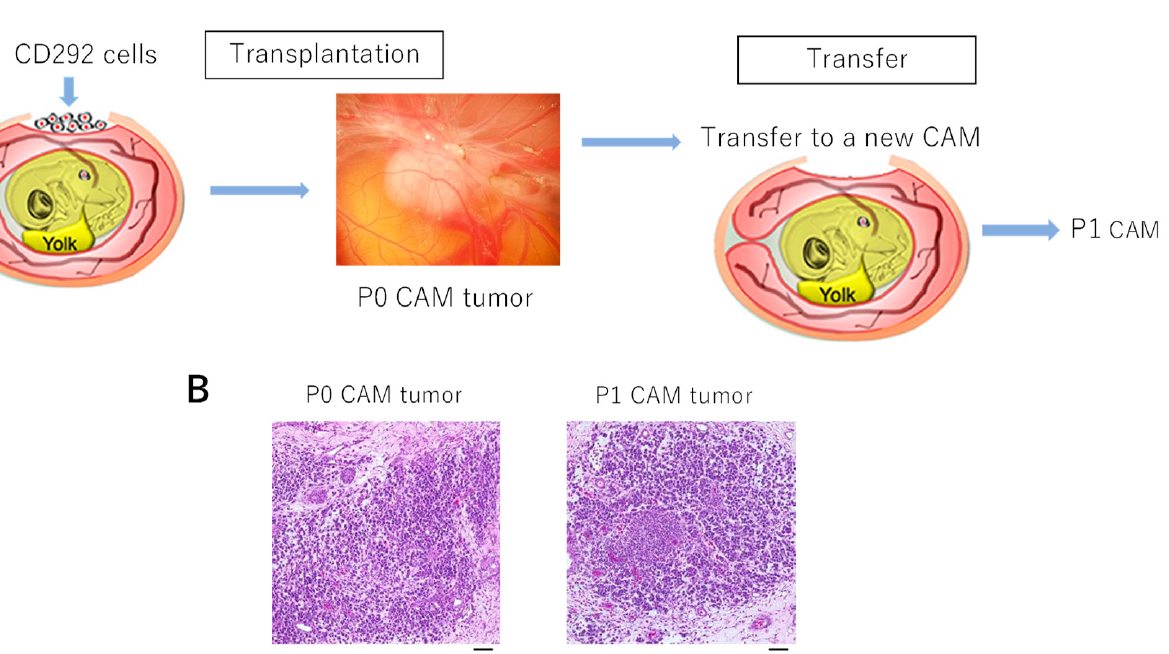
Figure 5. Passaging of CD-292 CAM tumor. ( A ): CD-292 cells were transplanted onto the CAM membrane to produce CAM tumor. This was cut out and minced into small portions and then transplanted onto a fresh chicken egg CAM membrane. ( B ): H&E staining of the passaged CAM tumor was compared with that of the original CAM tumor. Scale bar represents 0.05 mm.